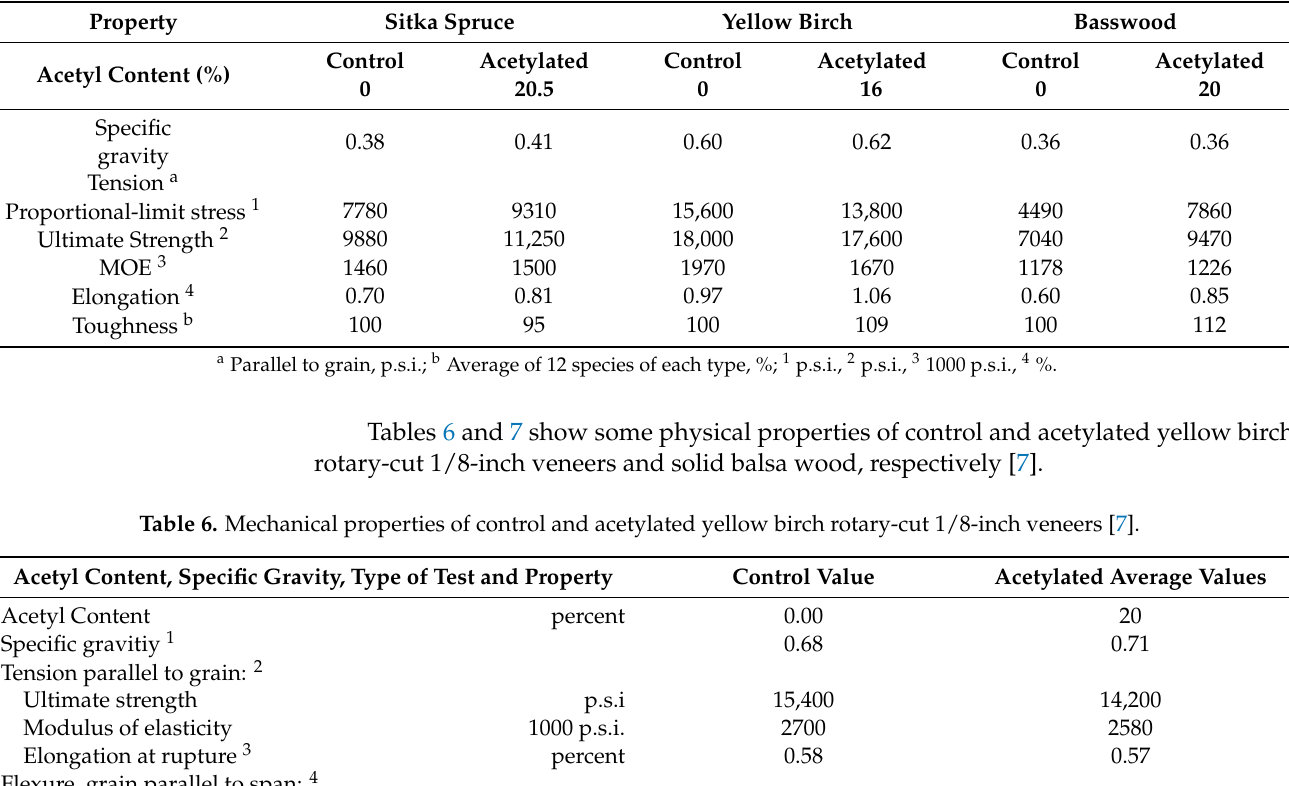
Table 5. Tensile and toughness properties of matched control and acetylated 1/16-inch rotary-cut veneers of Sitka spruce, yellow birch, and basswood [7].